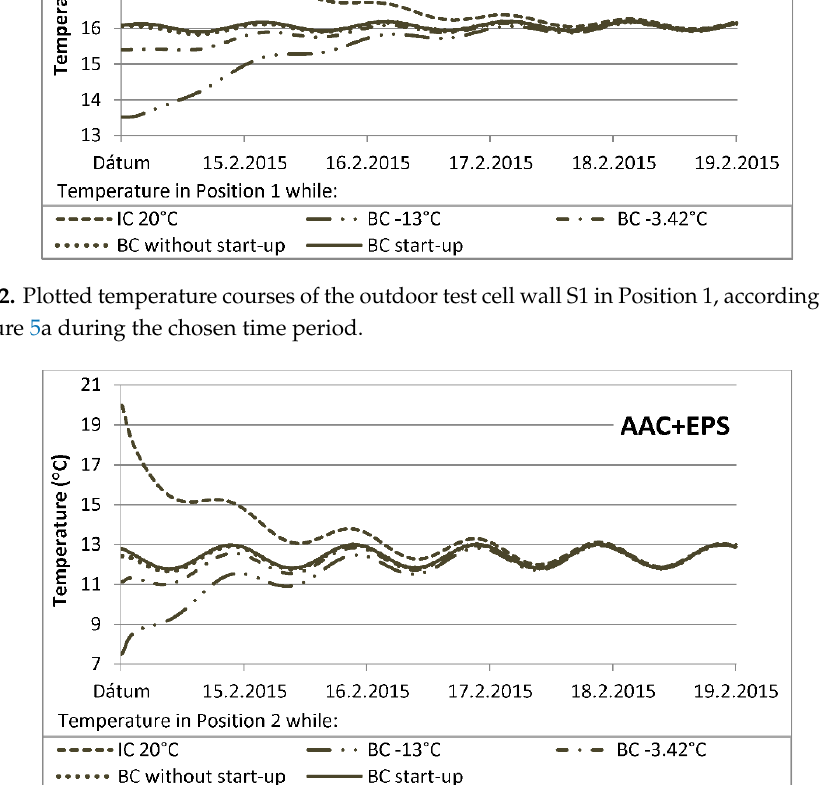
Figure 13. Plotted temperature courses of the outdoor test cell wall S1 in Position 2, according to Table 2 and Figure 5a during the chosen time period. Buildings 2019 , 8 , x FOR PEER REVIEW